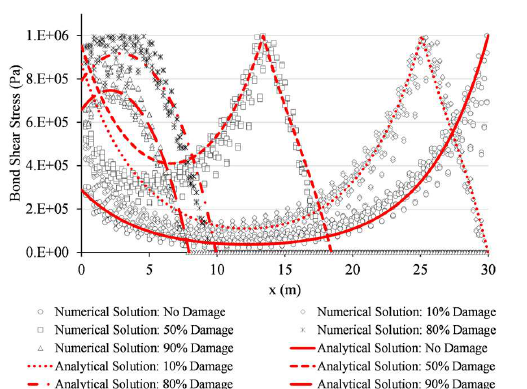
Figure 3. Bond shear stresses (in the z-direction) plotted against the bond centroid location along the interface length for a particle diameter of 0.5m. The bond shears are plotted for five points during the pull-out curve. The analytically predicted shear force is also plotted.